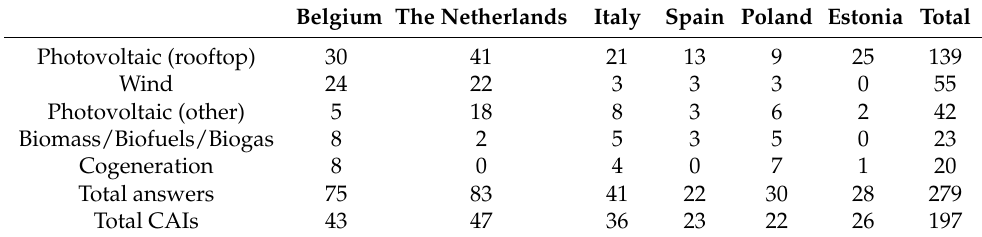
Table 9. Renewable Energy generation.